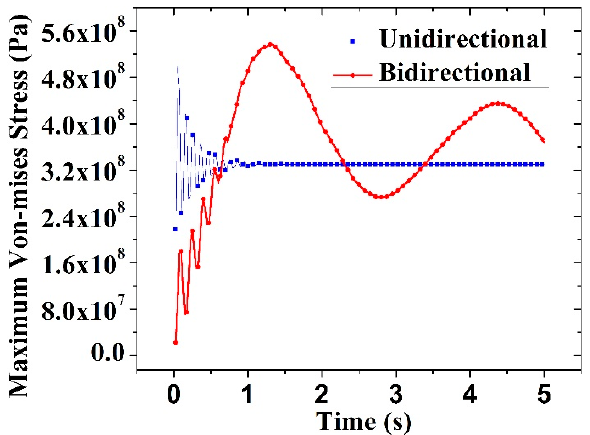
Figure 20. Maximum equivalent von-mises stress variation with time.